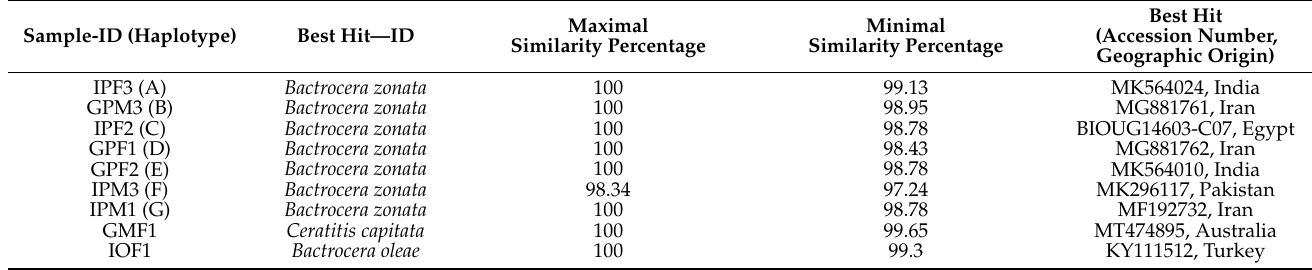
Table 4. Comparison of COI sequence data to the BOLD COI species